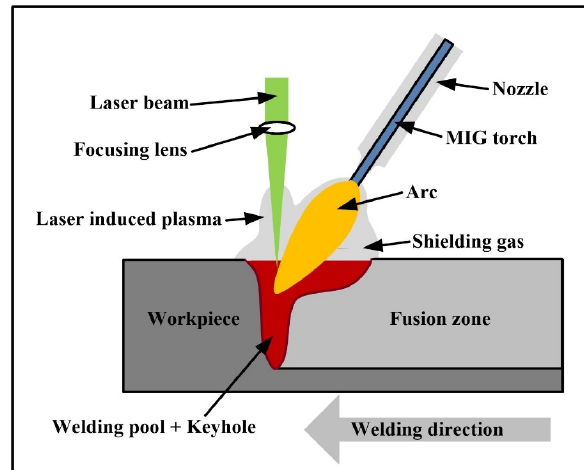
Figure 1. Schematic diagram of laser-MIG hybrid welding.